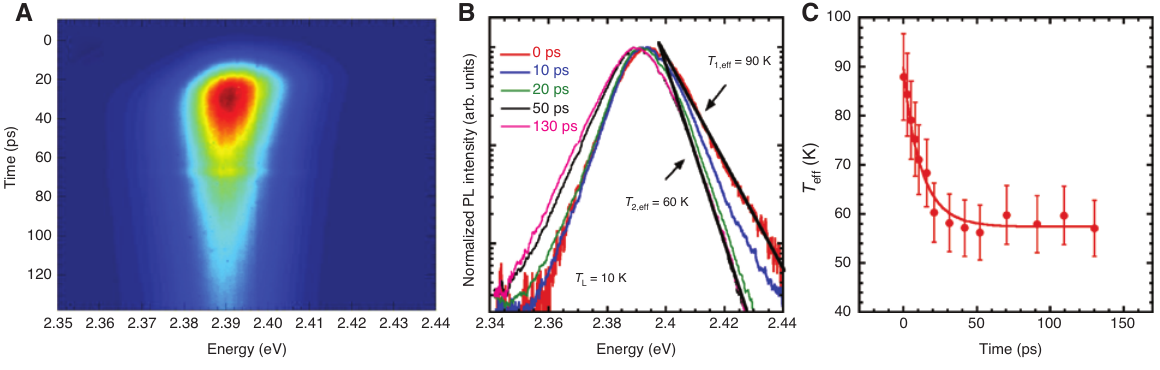
Figure 5: Spin-coated sample. (A) Streak image. (B) Normalized time-resolved photoluminescence (TR-PL) spectra where the exponential tail is evidenced in black. (C) Effective temperature of the carriers T as a function of time delay: the continuous line is a fit with Eq. (2). Measurements refer to a eff lattice temperature of 10